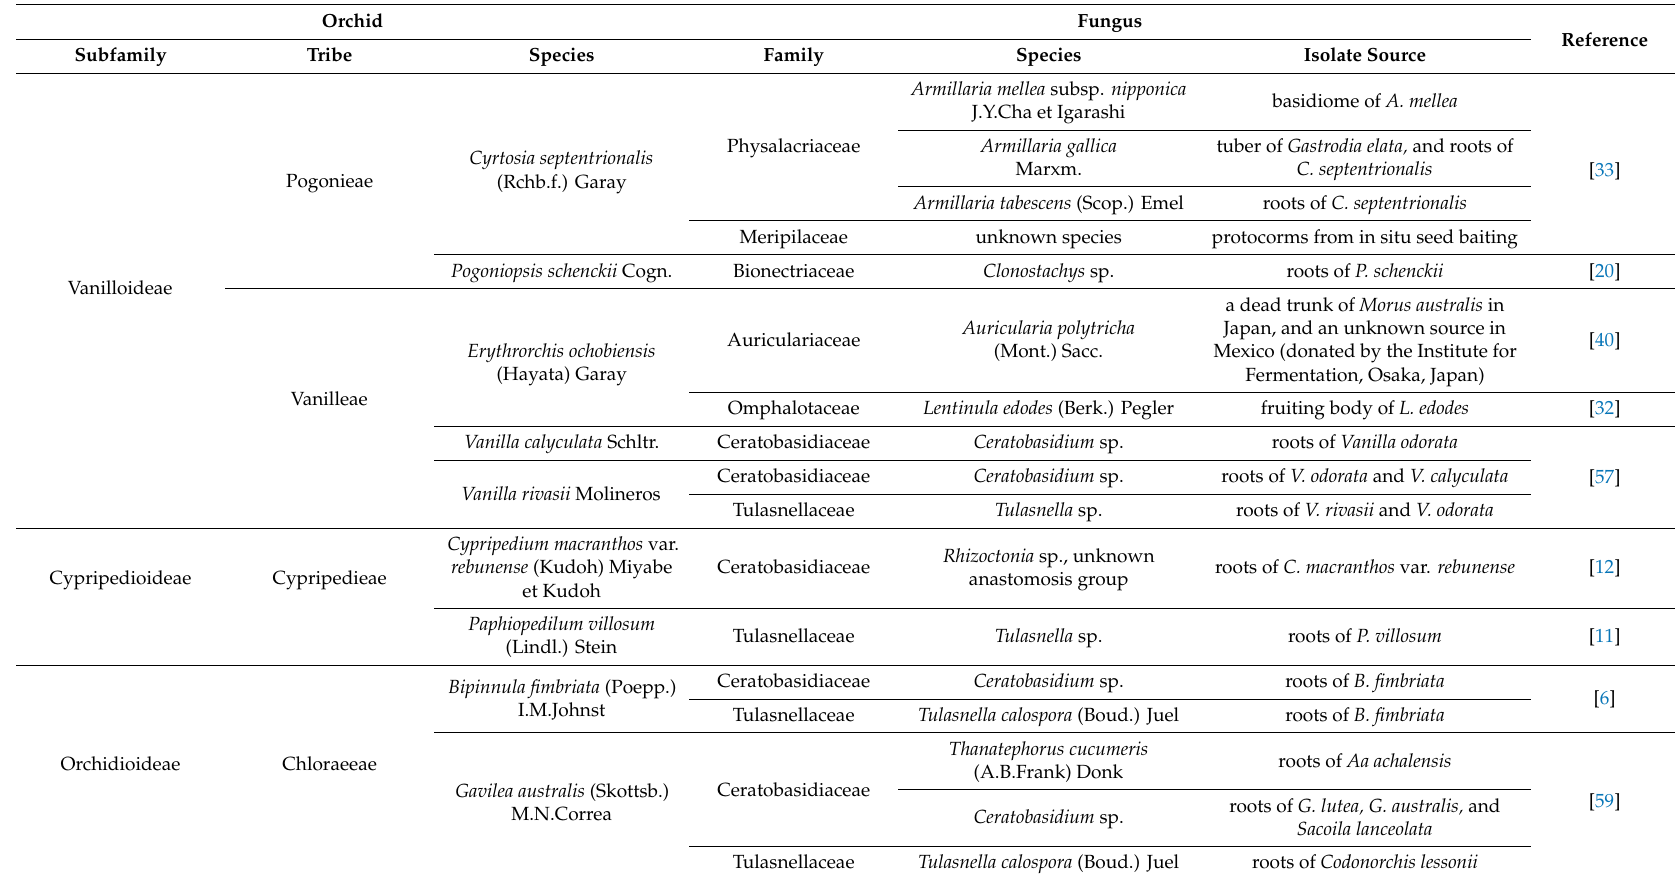
Table 1. Successful in vitro symbiotic germination attempts using orchid mycorrhizal